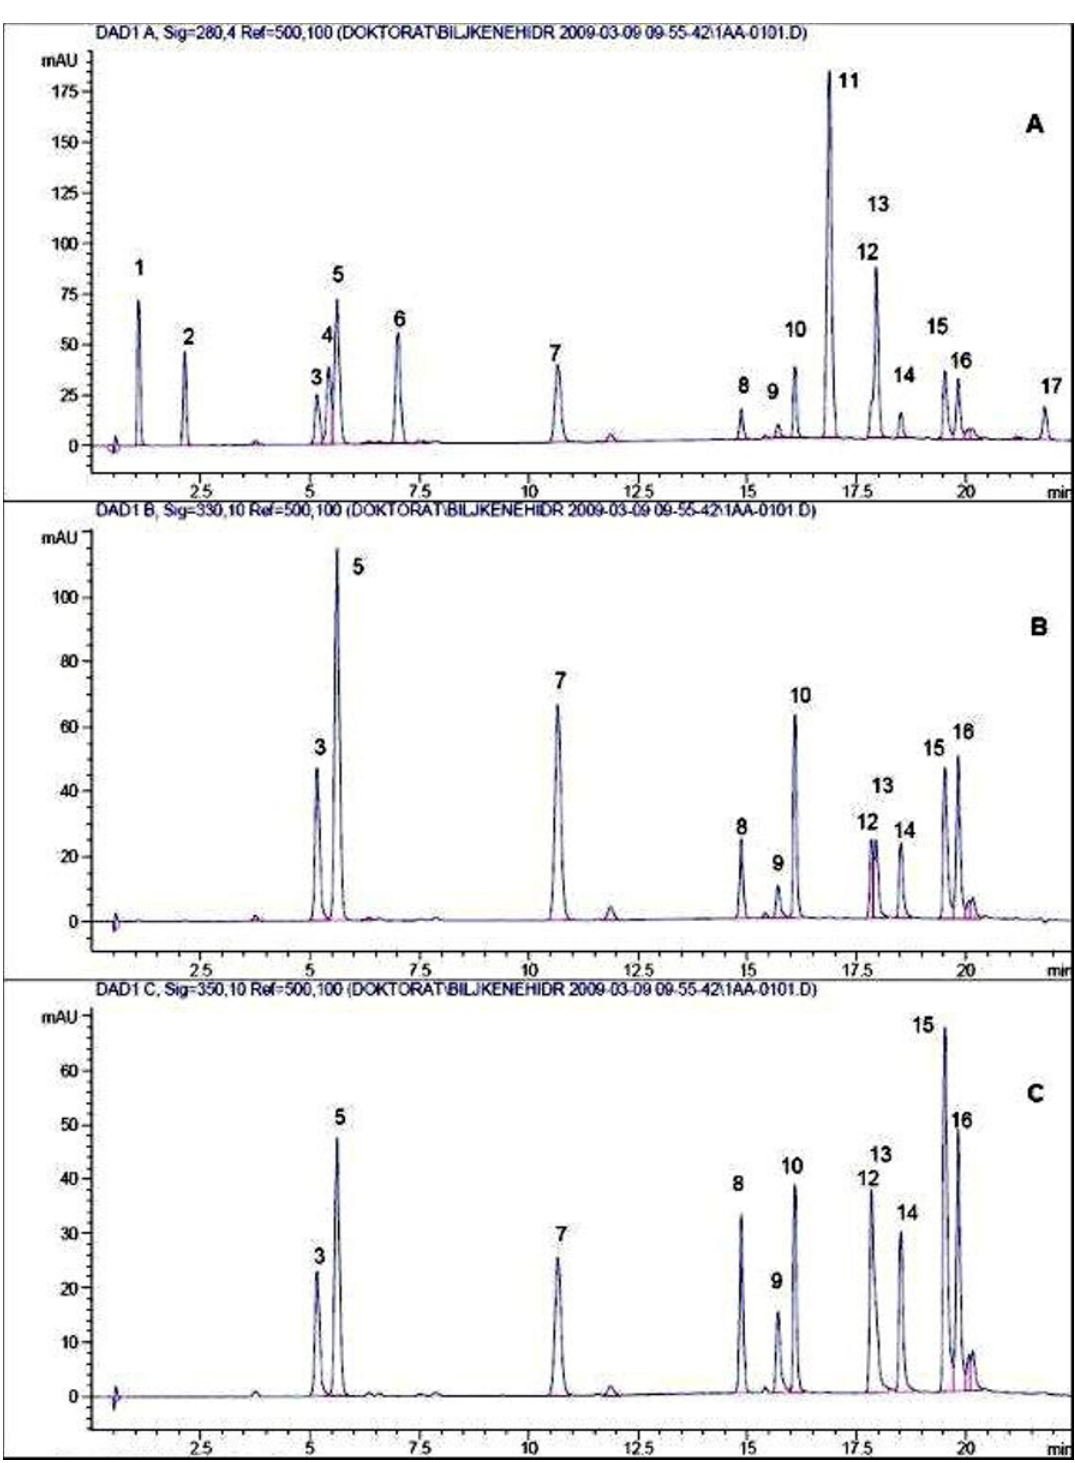
Figure 1. Chromatogram of external standard mixture, absorbance at A-280 nm, B-330 nm and C-350 nm: 1-gallic acid, 2-protocatechuic acid, 3-caffeic acid, 4-vanillic acid, 5-chlorogenic acid, 6-syringic acid, 7-ferulic acid, 8-rutin, 9-myricetin, 10-rosmarinic acid, 11- trans - cinnamic acid, 12-quercetin, 13-naringenin, 14-luteolin, 15-kaempferol, 16-apigenin and